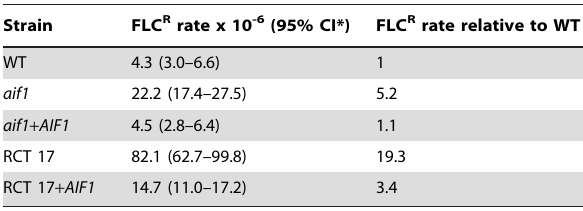
Table 2. FLC resistance rates.